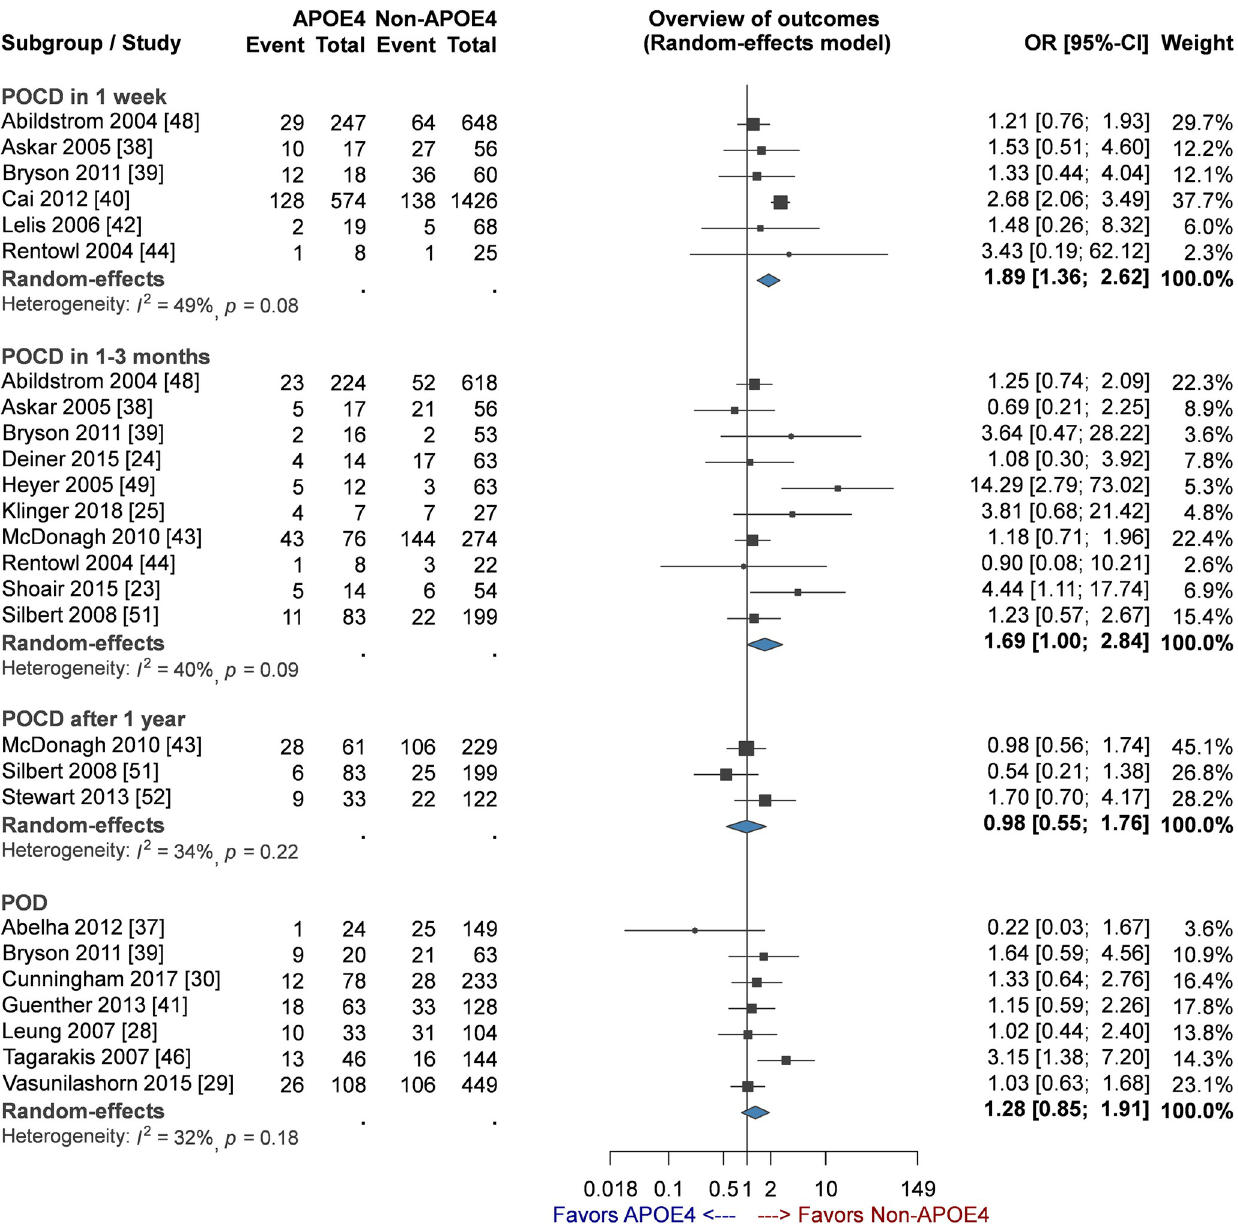
Fig 2. Forest plot of comparison of the risks of POCD or POD in patients with or without ApoE4. Abbreviations: POCD, postoperative cognitive dysfunction; POD, postoperative delirium. demonstrated heterogeneity in the outcomes of risk after excluding patients receiving cardio- vascular surgery. To minimize random errors and strengthen the conclusiveness of the results, TSA was applied. It clearly showed that the cumulative Z-curve (z score 3.83) crossed the upper monitoring boundary of TSA (alpha-spending adjusted z score 3.322) for harm (TSA adjusted 95% CI: 1.05 to 3.39; 3166 patients, six trials) establishing firm evidence of the positive result; however, the RIS of 9,095 patients was nearby but not reached (Table 4) (see S2 Fig, which illustrates the trial sequential analysis of the incidence of POCD or POD).